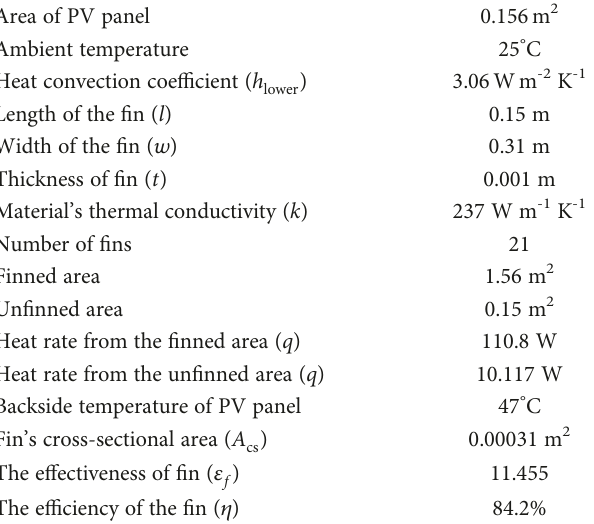
Table 2: Calculations of the fi ns ’ e ff